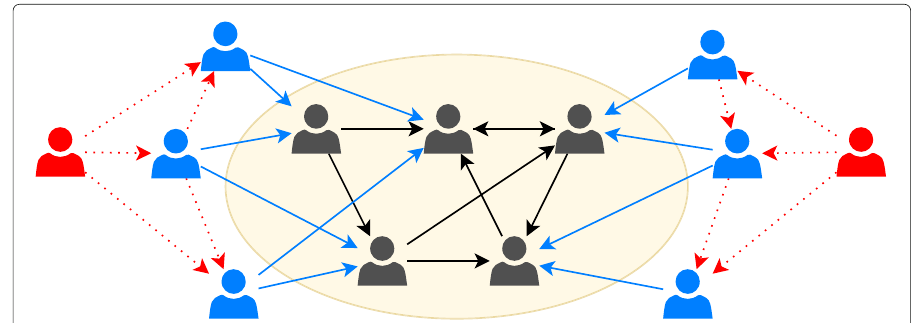
Fig. 2 Example of insiders and outsiders subnetworks. Insiders are nodes/authors coloured in black and outsiders are coloured in blue. Note that no links between outsiders exists (dashed red lines). Furthermore, no information exists of outsiders that do not cite any insiders (coloured in